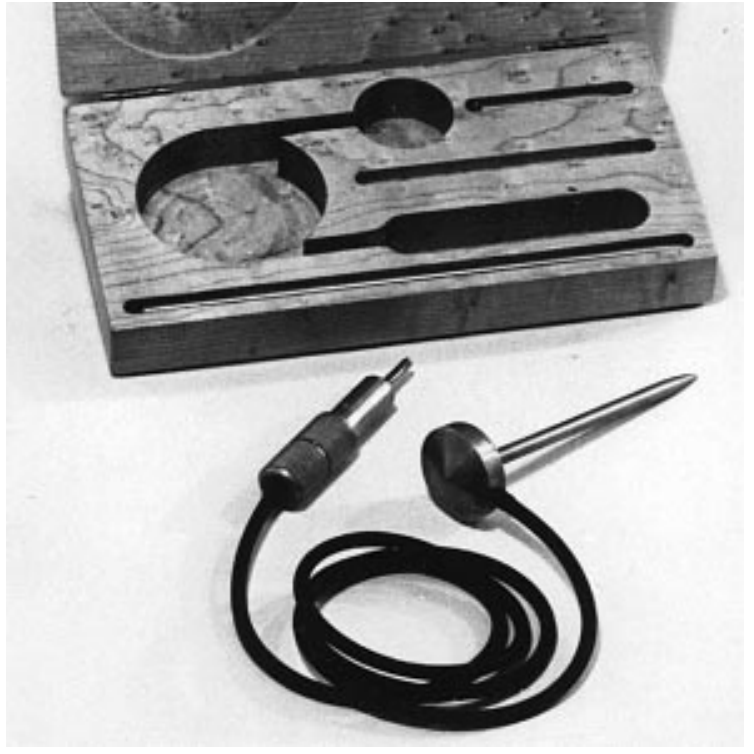
Fig. 2. The first commercial piezoelectric accelerometer (B&K, about